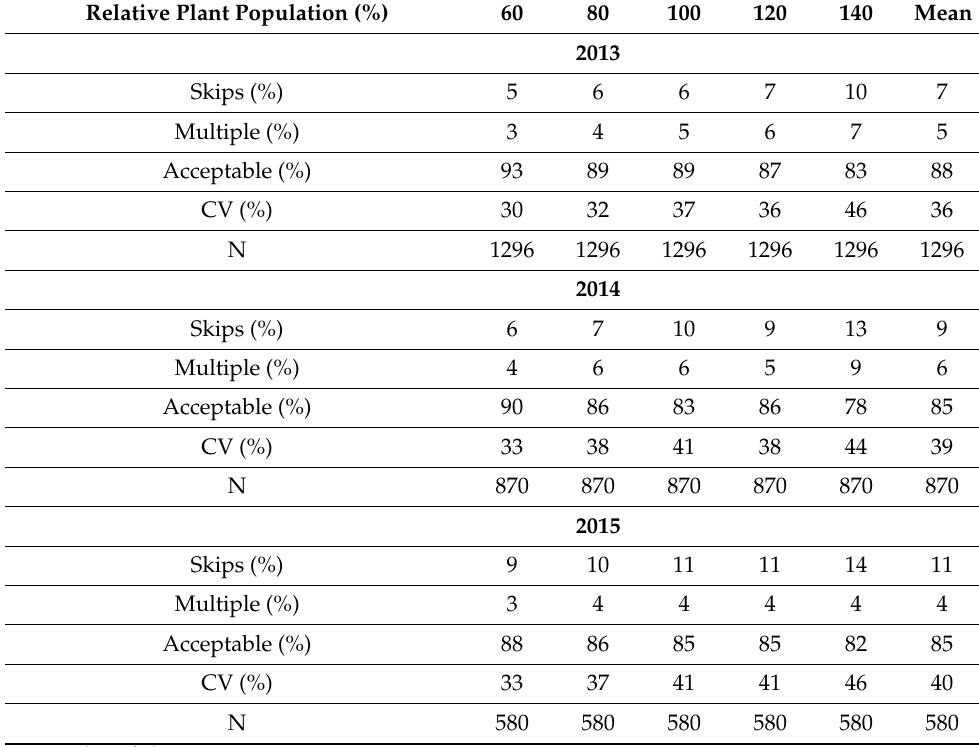
N = number of observations.